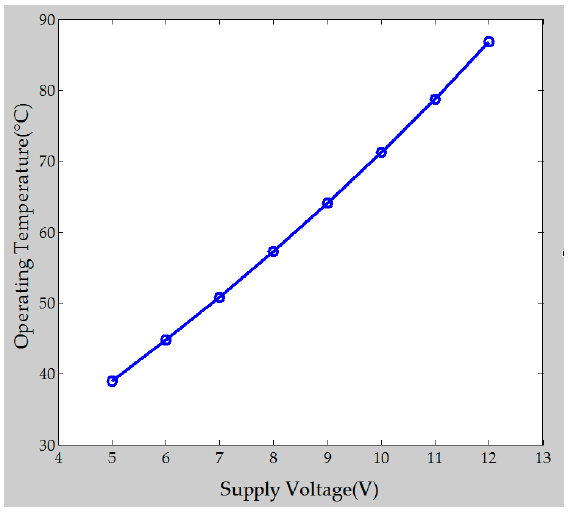
Figure 8. Operating temperature with respect to applied heater voltage.